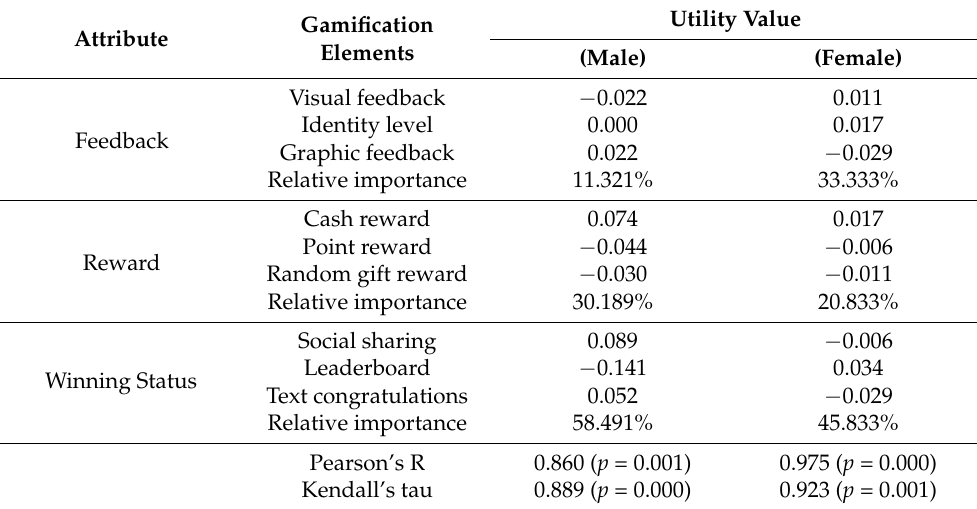
Table 8. Utility value of attribute levels classified by